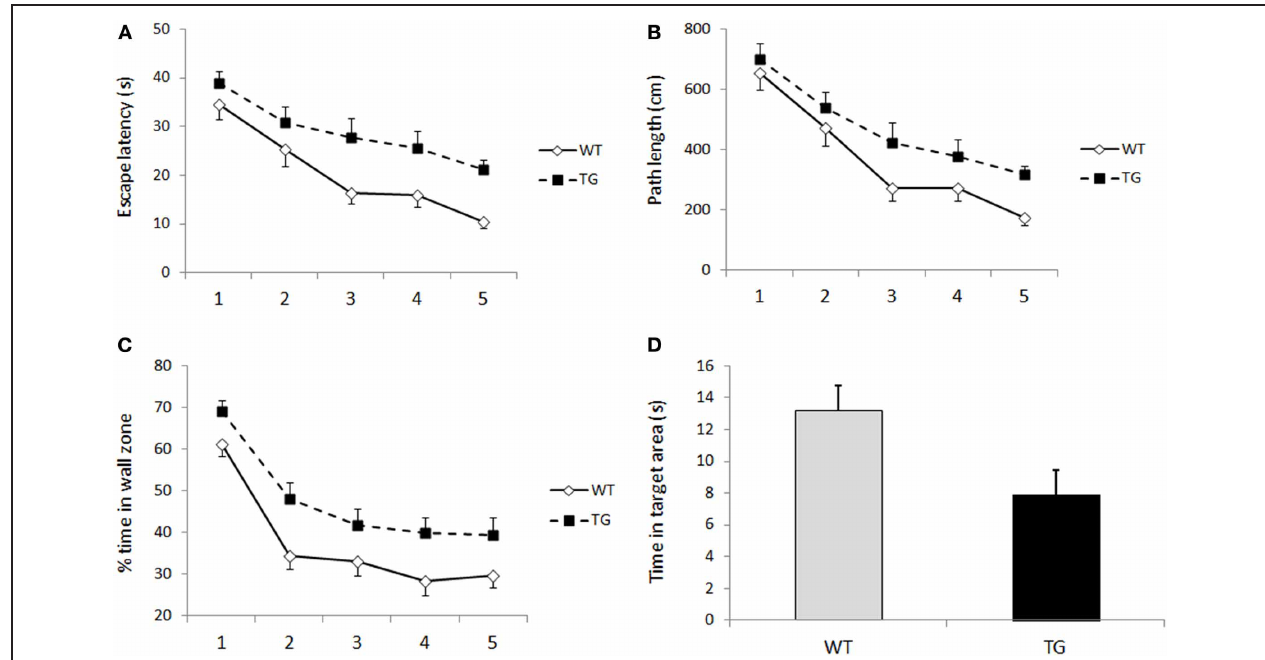
FIGURE 2 | (A) Escape latency over five days of Morris swim task acquisition in 12-month-old male APPSwe/PS1dE9 (tg, n = 13) mice and their wild-type littermates (WT, n = 15). Genotype difference was significant ( p = 0 . 001, ANOVA with repeated measures). Group means and SEMs are shown. (B) Corresponding plot for path length ( p = 0 . 01, ANOVA with repeated